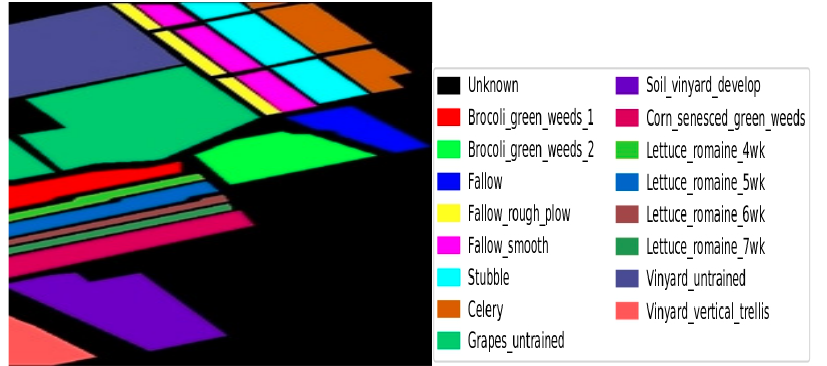
Figure 5. Salinas dataset with colour codes .